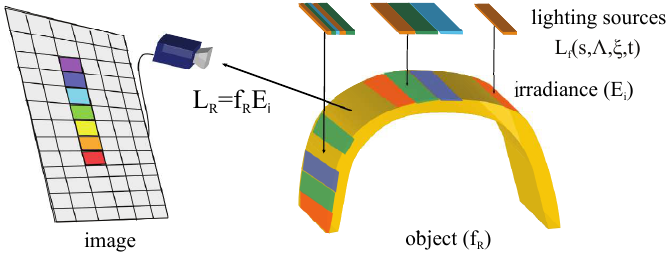
Figure 7. Parameters involved in the scene radiance L R : object reflectance ( f R ) and irradiance ( E ) incident on the